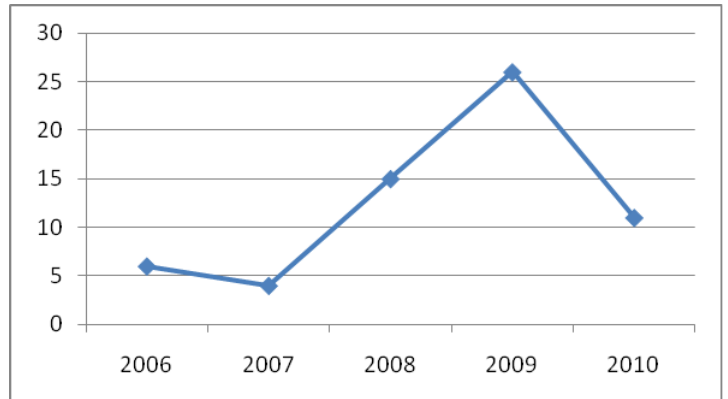
Figure 6. Growing of the study of endophytic fungi from 2006 to